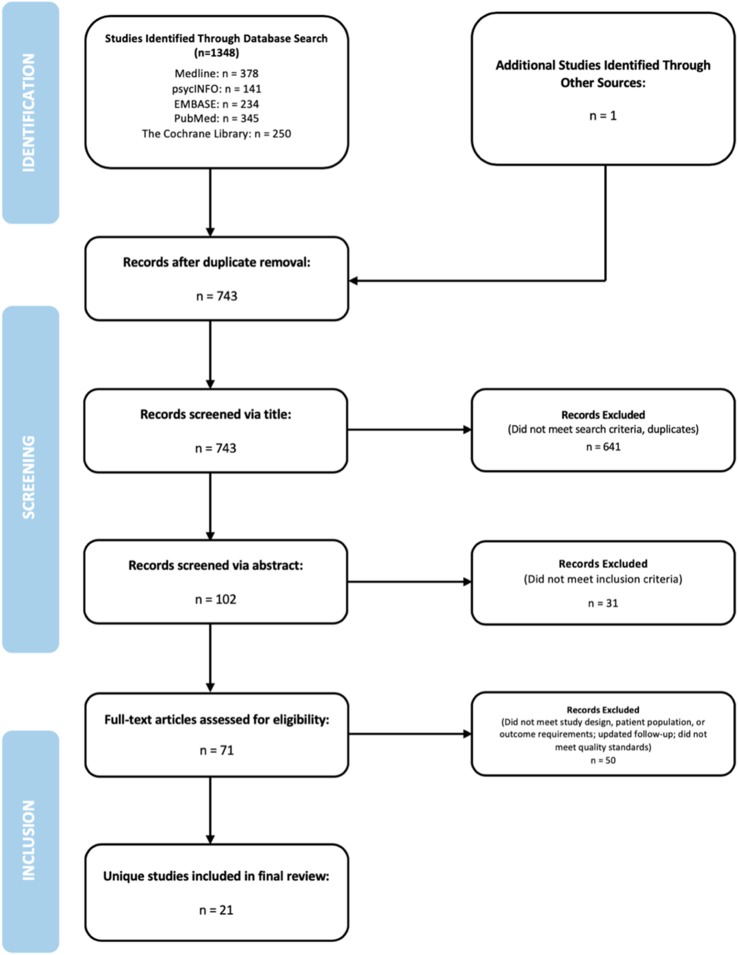
Study flow diagram.